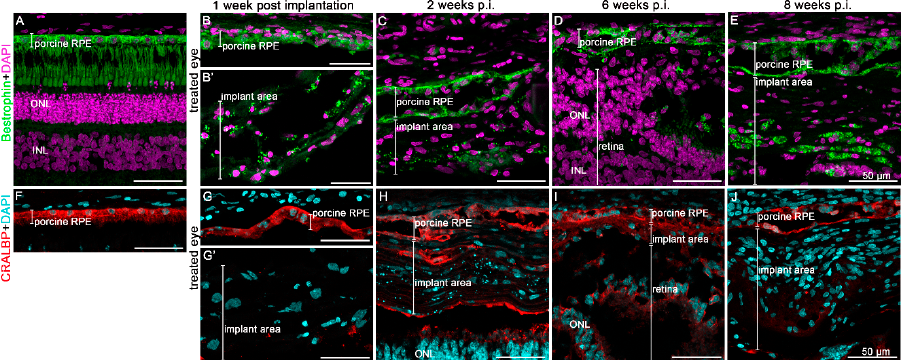
from the minipig RPEs—they did not form a confluent layer, and were less capable of keeping the inner and outer retinal segments intact.